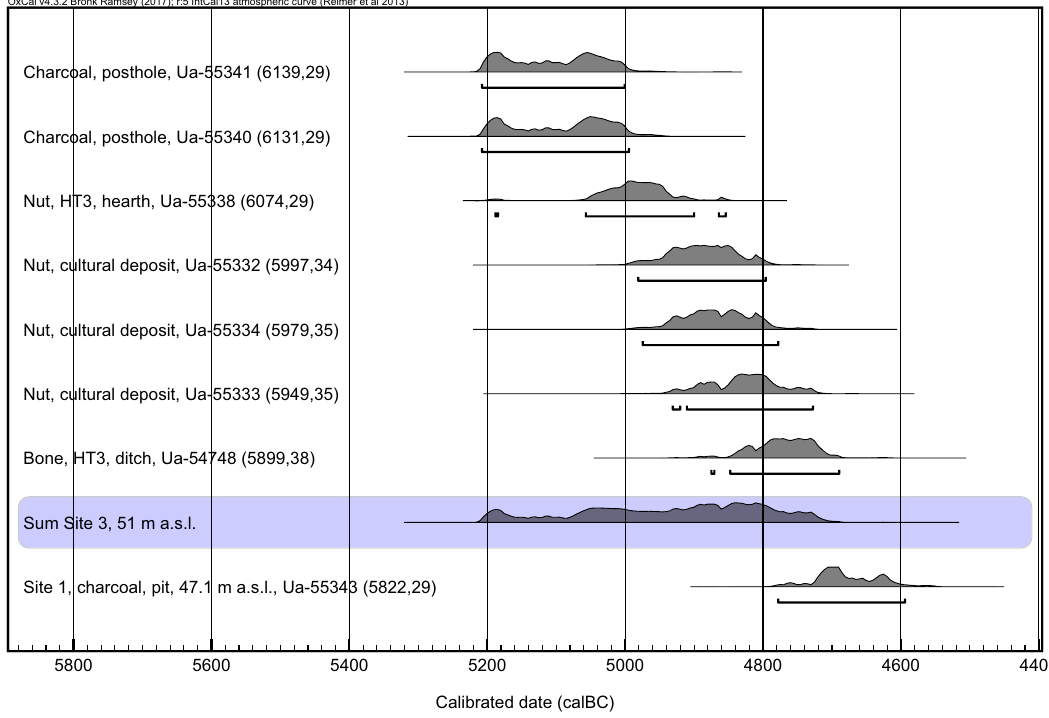
Figure 9: Radiocarbon dates from the sites in